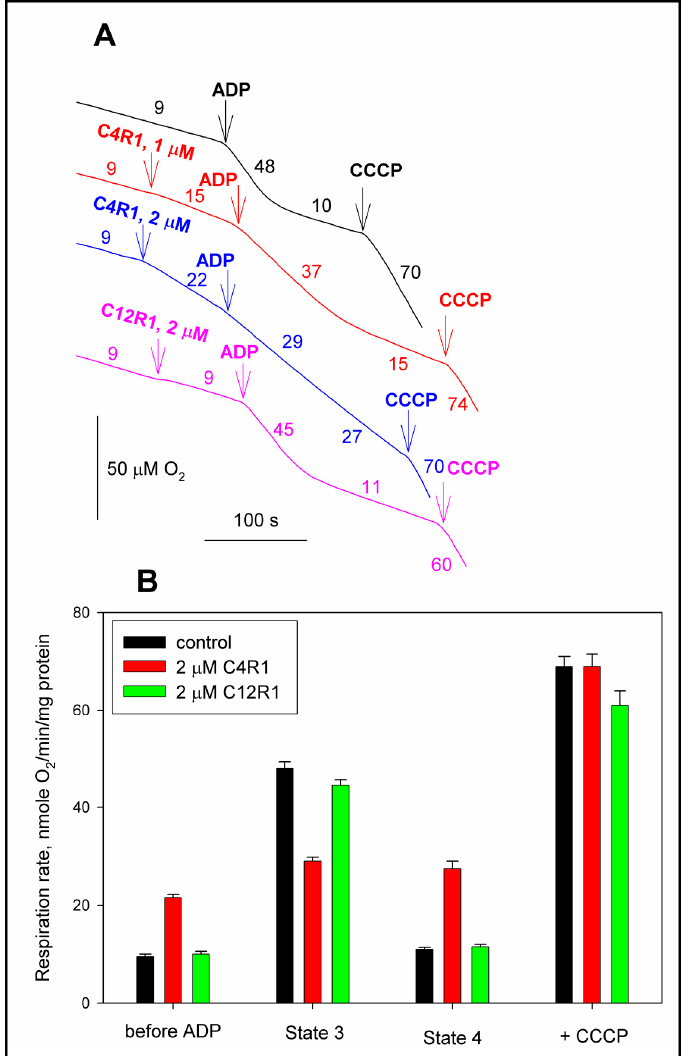
Figure 2. The effect of C4R1 and C12R1 on coupled (state 4), uncoupled (state 3u) and phosphorylated (state 3) respiration. ( A ) Traces of respiration of rat liver mitochondria (RLM). Substrate, succinate (5 mM) supplemented with 2 µ M rotenone. Additions were indicated: 100 µ M ADP, 0.2 µ M CCCP. For other conditions, see the Materials and Methods. Numbers on curves correspond to mitochondrial respiration rates in nmoles O 2 /min/mg protein. ( B ) Statistics of the effect of C4R1 and C12R1 on the respiration of RLM. Results are expressed as mean ± SD (n = 3) with p < 0.001 (Student’s test) between black and red columns in groups “before ADP”, “State 3” and “State 4”.